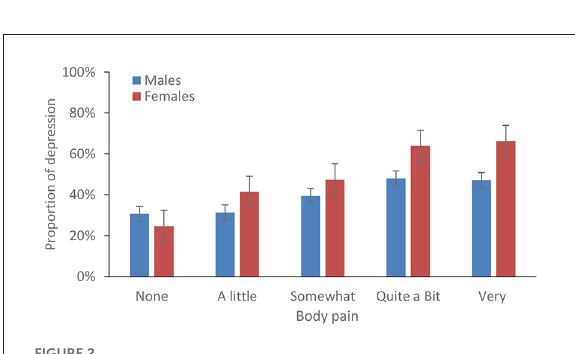
FIGURE2 Percentage of depressive symptoms among patients with stroke by the degree of body pain and gender,